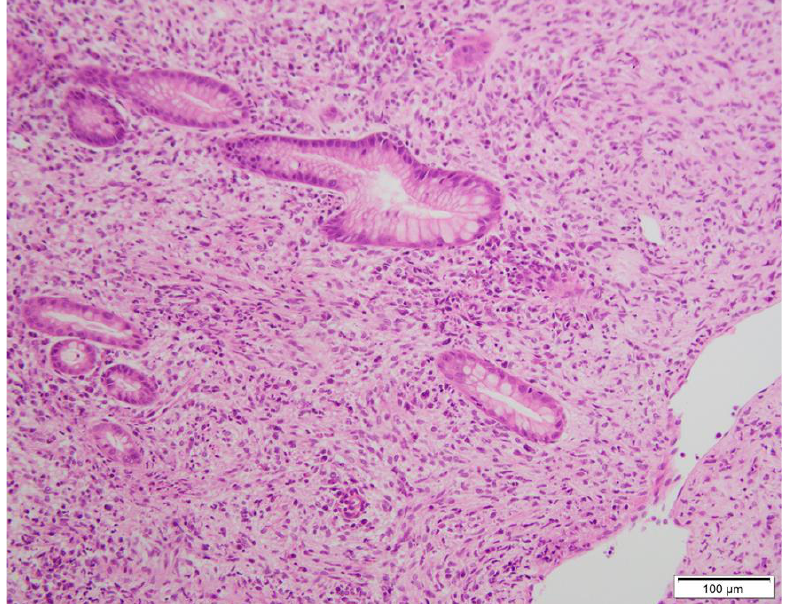
Figure 3. Gastroscopy biopsy tissue H&E stain can be seen from scattering cells. (H&E stain, × 200). According to the form of tumour cells, GIST is divided into three major subtypes: spindle cell, epithelial sample, and mixed type. The rare types include de-differentiated types. Spindle cell accounts for 50% to 70%. It is mainly composed of scattering cells with relatively consistent morphology. The density, heterogeneity, and nuclear split elements of tumour cells vary for each case. Some GIST cases can be seen on the nuclear end. Slipper cells are mostly arranged or intertwined, and sometimes there are a variety of arrangements, such as organs, fake chrysanthemum-shaped groups, or fences [15].